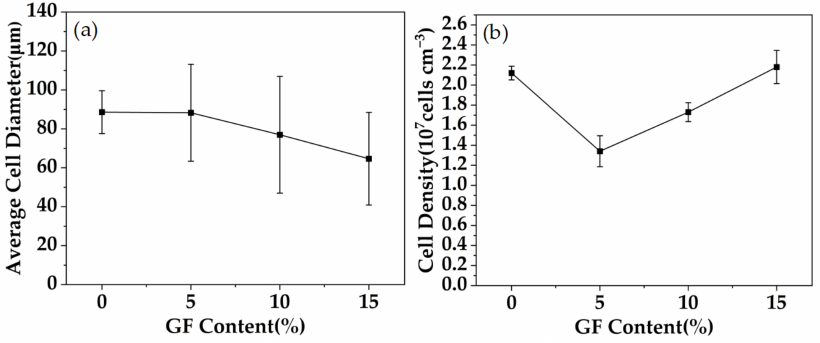
Figure 7. Foam PC and PP/GF composites under different GF loads: ( a ) changes in average cell diameter and ( b ) cell